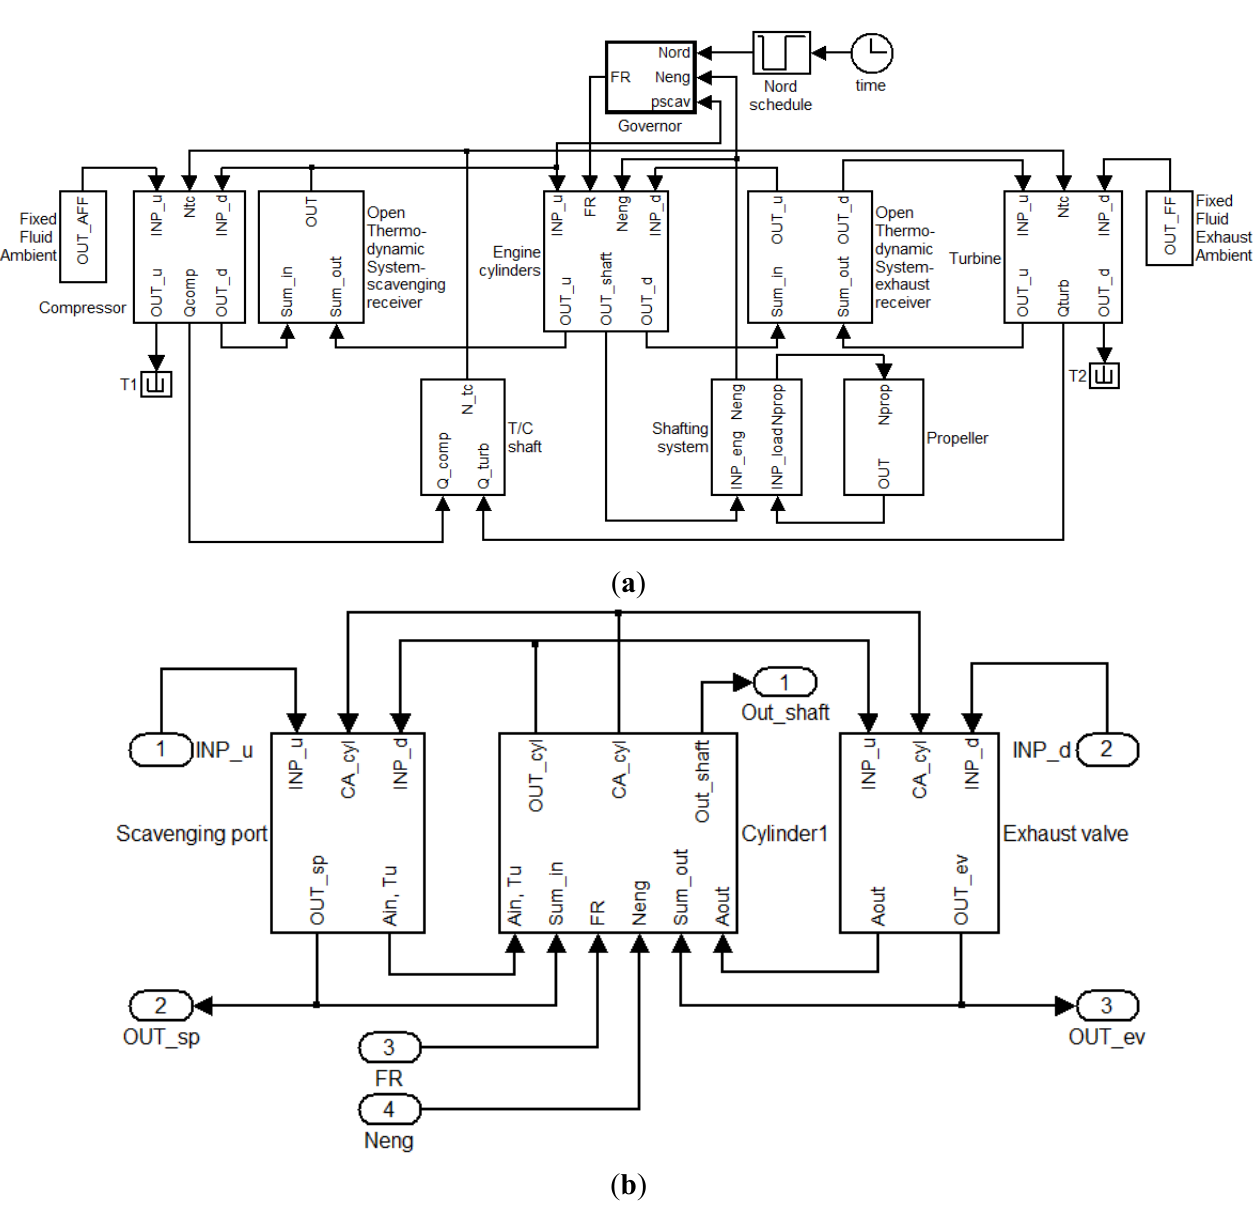
Figure 1. ( a ) Zero-dimensional two-stroke engine model implemented in MATLAB/Simulink environment; ( b ) Cylinder No. 1 block along with each scavenging ports and exhaust valves